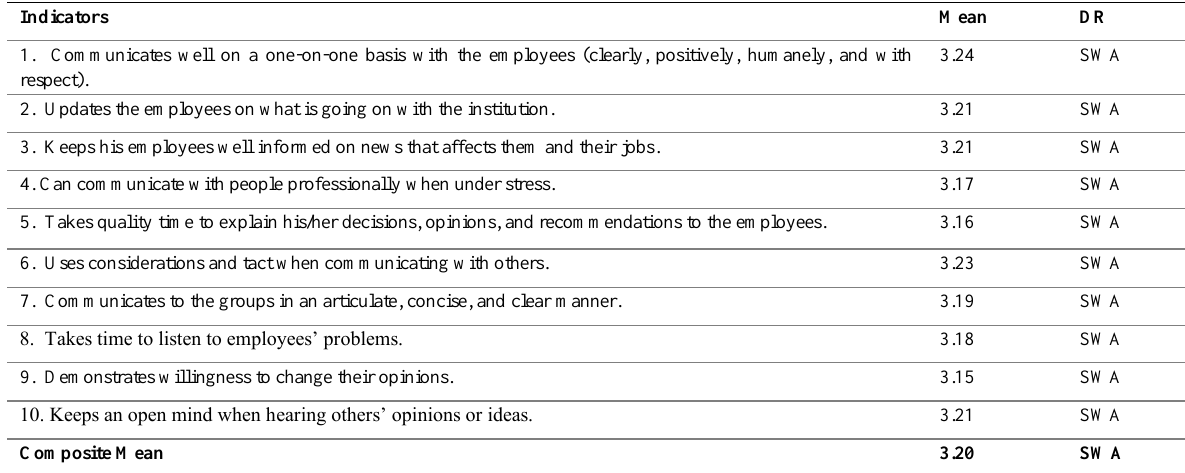
Table 1: The Leadership Skills of administrators of Divine Word Colleges in the Ilocos Region in terms of Communication Indicators